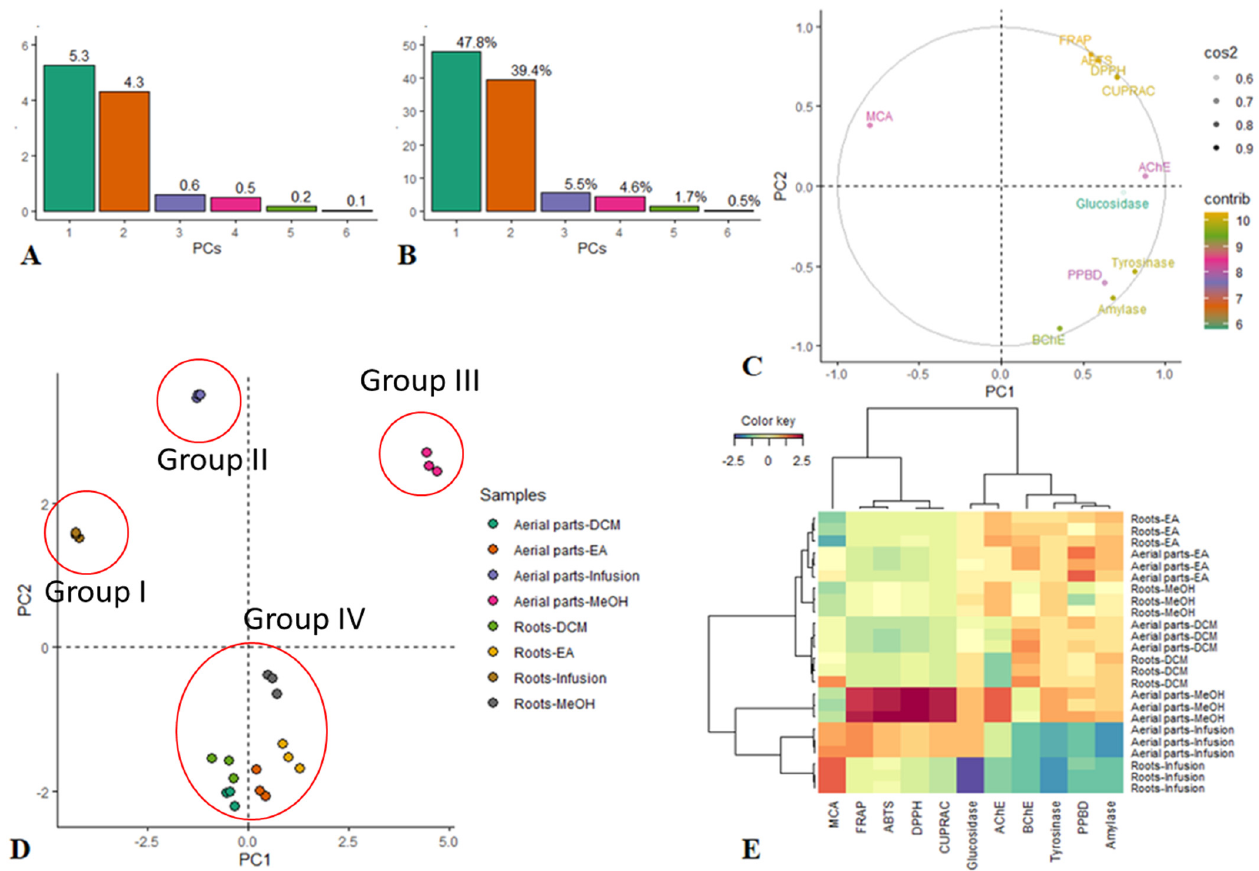
Table 8. Relationship between total phenolics and flavonoids contents and biological activities (Pearson correlation (R)).